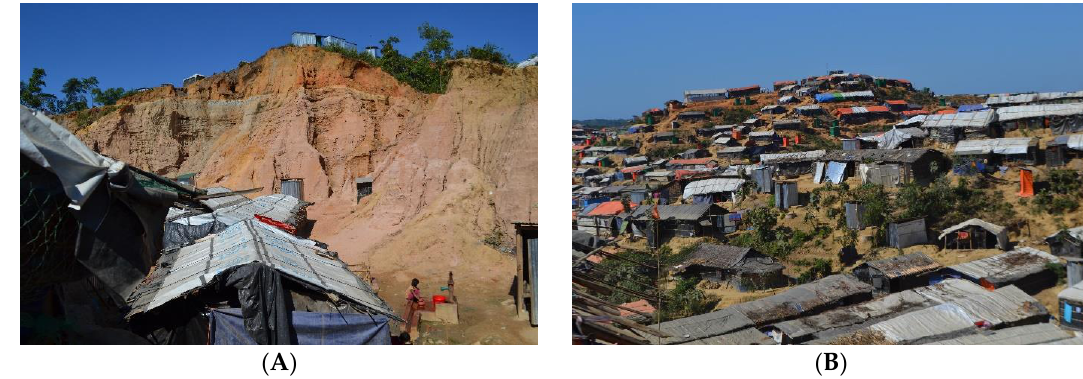
Figure 8. Photographs of refugee camps at the Balukhali site. ( A ) Makeshift settlements on razed hills and the hill base, showing the ecological damage and potential threat of mudslides during the monsoon season. ( B ) A makeshift settlement inside the degraded forested land, depicting destruction of habitat and natural environment. Source: Collected during field survey on 28 December 2017.